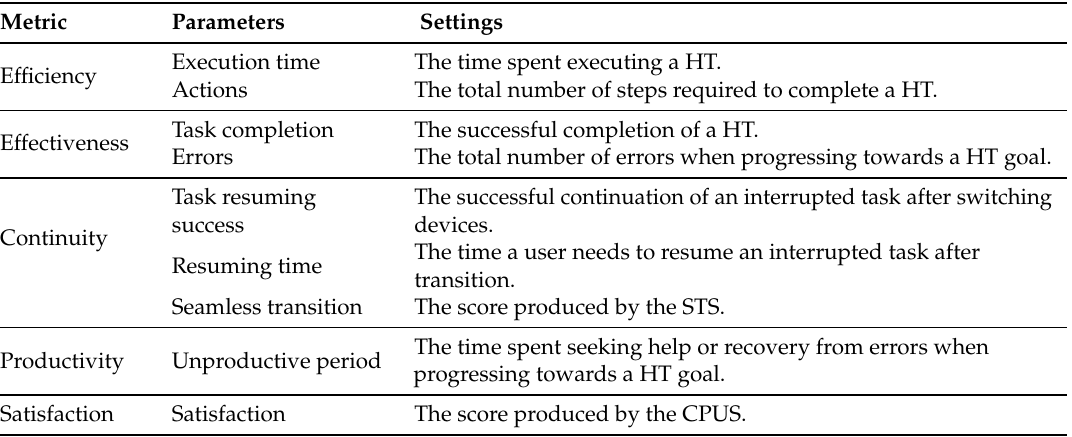
Table 1. Definition of cross-platform usability metrics.